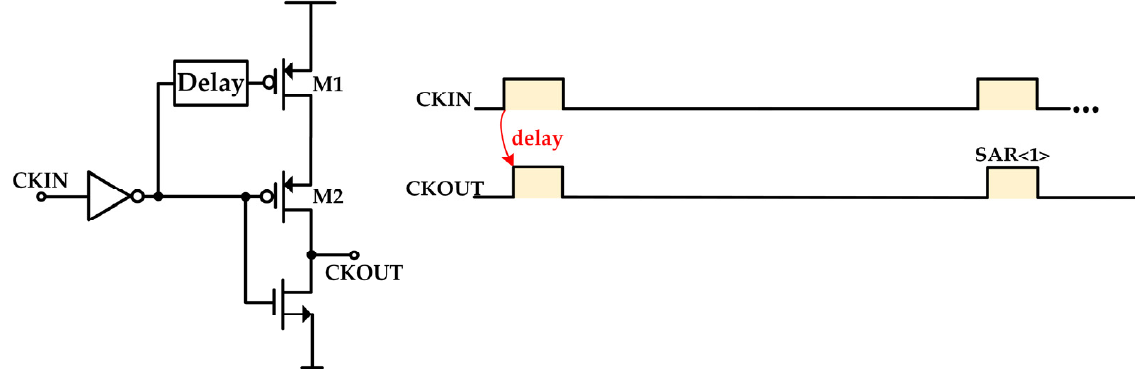
Figure 5. The proposed pulse adjustor.